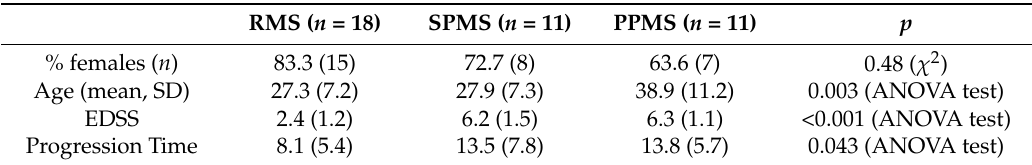
Table 3. Characteristics of MS patients according to clinical classification. SD: standard deviation; EDSS: expanded disability status